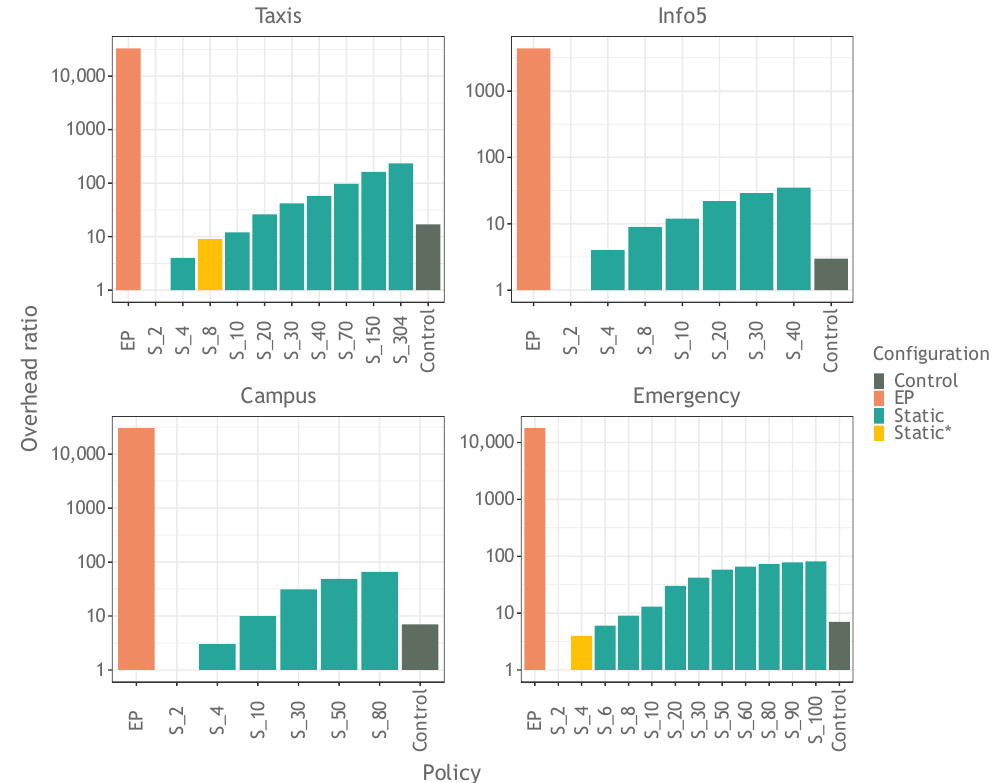
Figure 9. The overhead percentage for the different forwarding policies per scenario in a logarithmic